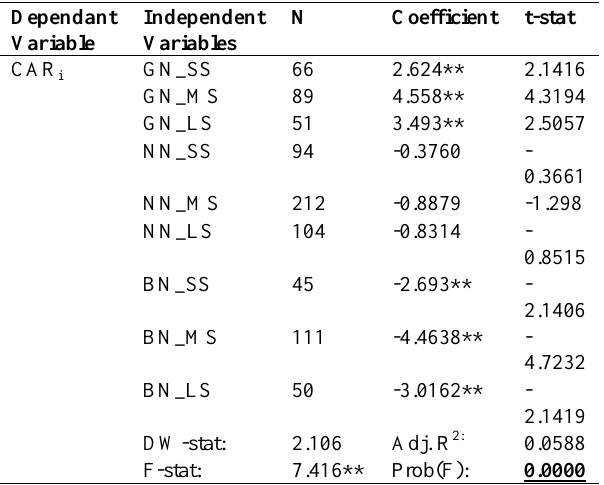
Note: The table represents the multiple regression results of the combined effects of news and size on overreaction.